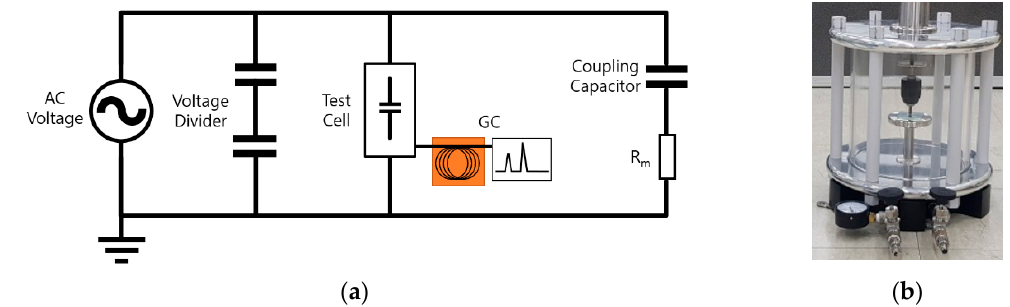
Figure 1. ( a ) Schematic diagram of the partial discharge experiment, the measuring system and ( b ) the test cell.